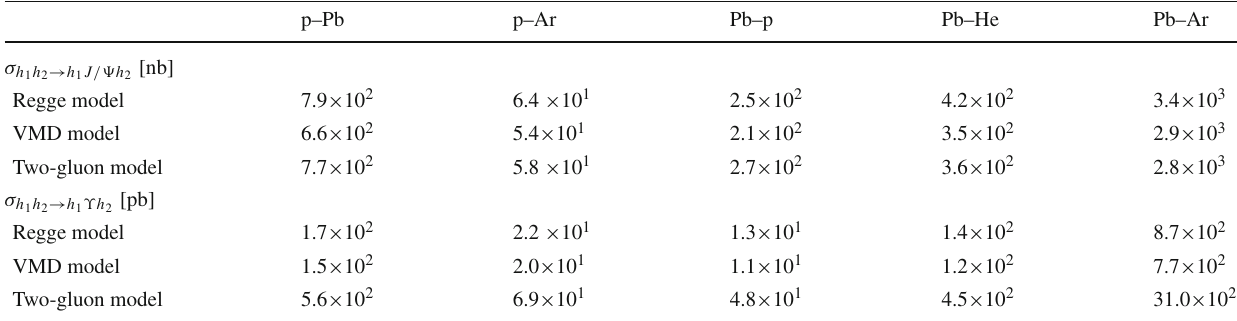
Fig. 2 Energy dependence of the γ p → J /(cid:2) p (left panel) and γ p → ϒ p (right panel) total cross sections predicted by the two-gluon, VMD and Regge models. Data from Refs. [58,71–78] Table 1 Total cross sections for the exclusive J /(cid:2) and ϒ photoproduction in fixed-target collisions at the LHC considering different models for √ s NN = 100 (69) GeV for pA ( PbA ) the γ p → V p cross section. We assume